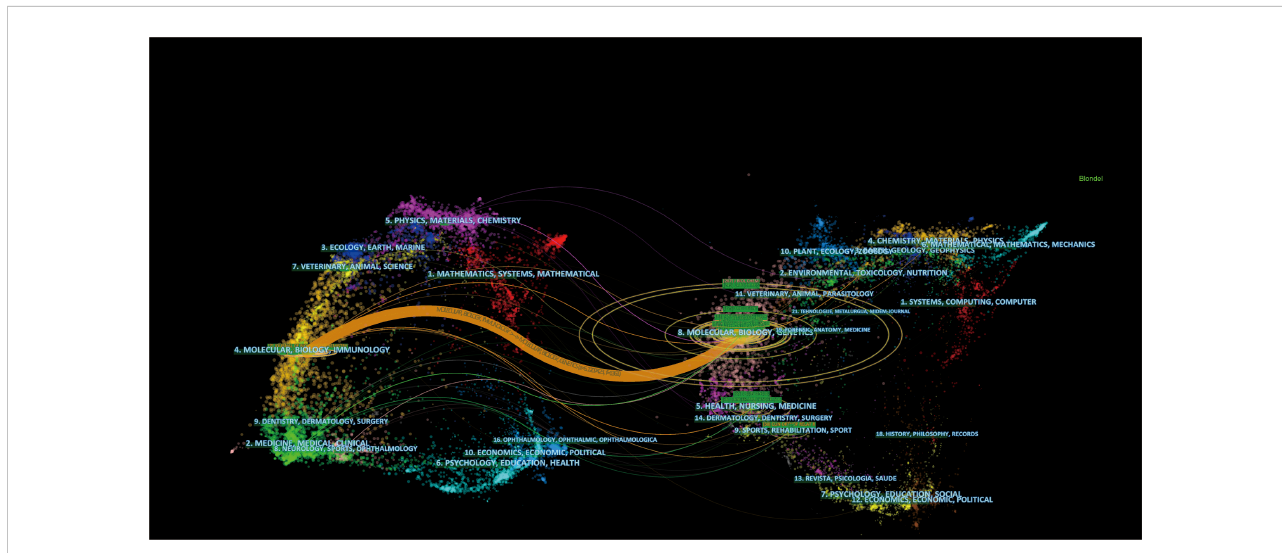
FIGURE 11 The dual-map overlay of journals related to top 100 most cited references in MMP-OS research. The citing journals were at left, the cited journals were on the right, and the colored path represents citation